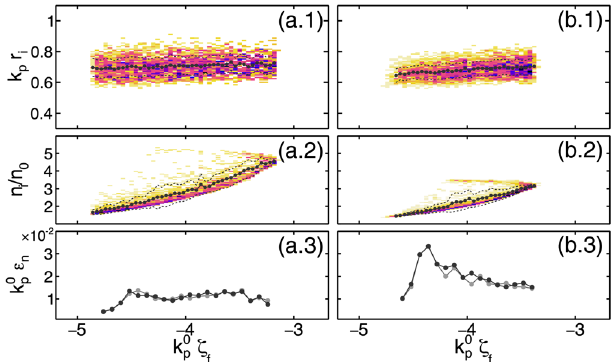
FIG. 11. Initial radius (top) and density (middle) distributions for trapped electrons as a function of their final phase positions, for the cases (a) and (b) in Fig. 7. Black dots indicate the average values and dashed lines (cid:3) 1 rms. Sliced normalized emittance in horizontal (black) and vertical (gray) directions after ∼ 5 cm of